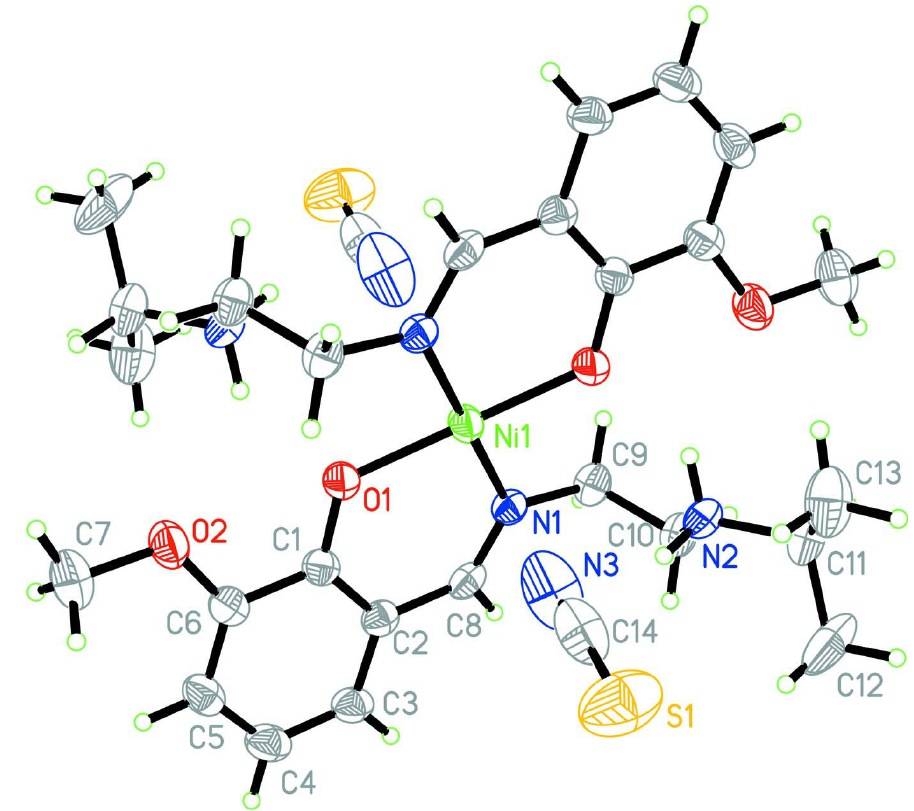
Figure 1 The molecular structure of complex (I), with displacement ellipsoids drawn at the 30% probability level. Bis{2-[2-(isopropylammonio)ethyliminomethyl]-6-methoxyphenolato}nickel(II)